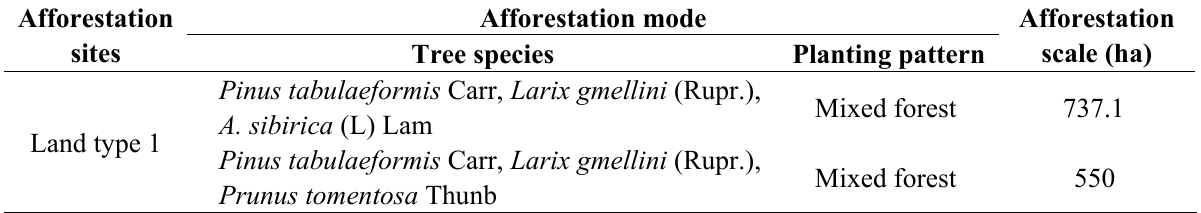
Table 1. Originally recommended scheme for the CDM forestry